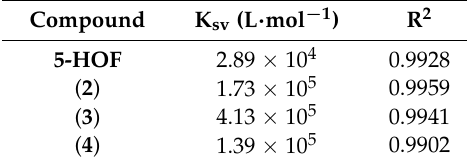
Table 5. Quenching constants of the interaction between the tested compounds and CT-DNA-EB